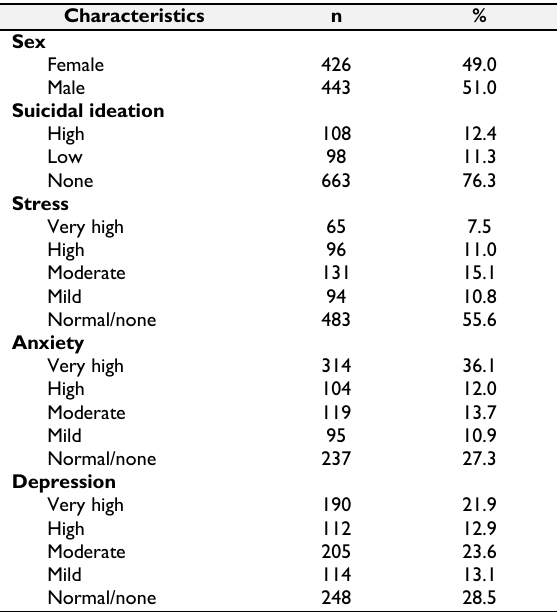
Table 1 Characteristics of research respondents (N = 869)